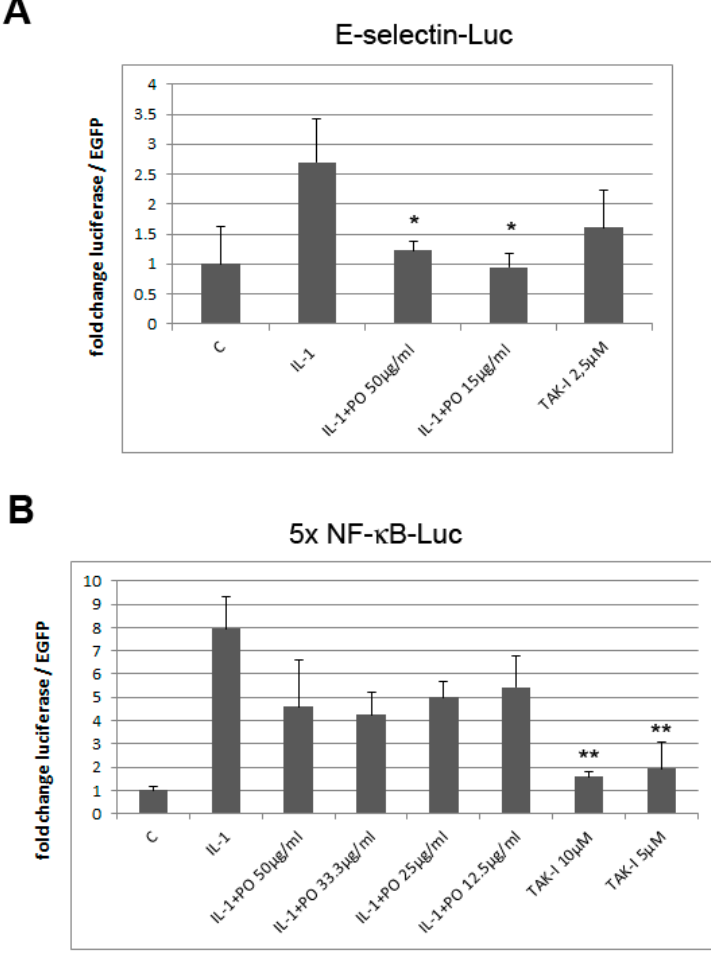
Figure 3. PO inhibits E-selectin promoter and NF- κ B activity. HUVEC were transfected with either an E-selectin ( A ) or a NF- κ B luciferase reporter construct (5xNF- κ B luc; ( B )) and EGFP as internal control, pretreated with PO (or TAK inhibitor as positive control) and stimulated with IL-1 as indicated. Luciferase levels were determined after 16 h and are shown as relative levels normalized to EGFP. Triplicate samples were analyzed. * p < 0.05, ** p < 0.01 as compared to IL-1 stimulation; C: unstimulated control.